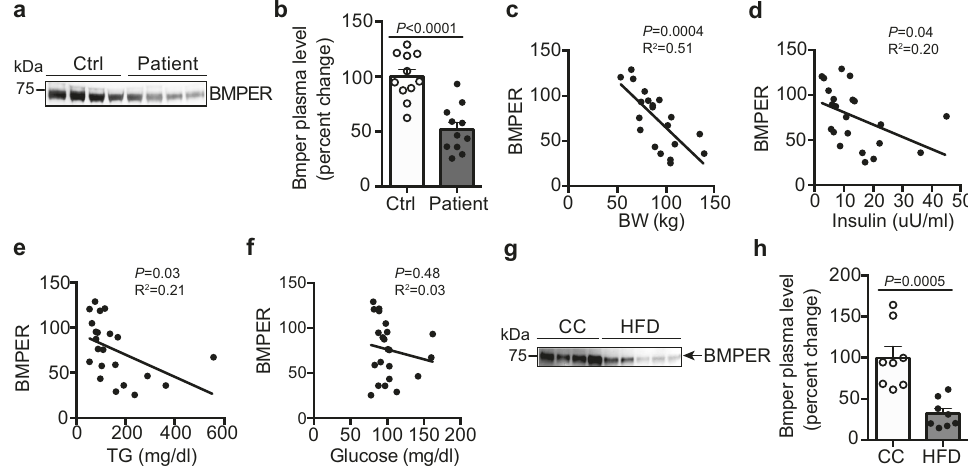
Fig. 3 BMPER plasma level decreases in metabolic syndrome patients and DIO mice. a , b BMPER plasma levels were decreased in metabolic syndrome (MS) patients 25 . c – f BMPER plasma level was associated with body weight (BW), insulin, and triglyceride (TG) plasma levels in MS patients. Correlation was computed for Pearson correlation coef fi cients with an assumption of Gaussian distribution. g , h BMPER plasma level was decreased in HFD-fed mice. n = 11 individuals ( b – f ) and 8 mice ( h ). Data are presented as mean values ± SEM. Analysis was unpaired two-tailed Student ’ s t test (for b , h